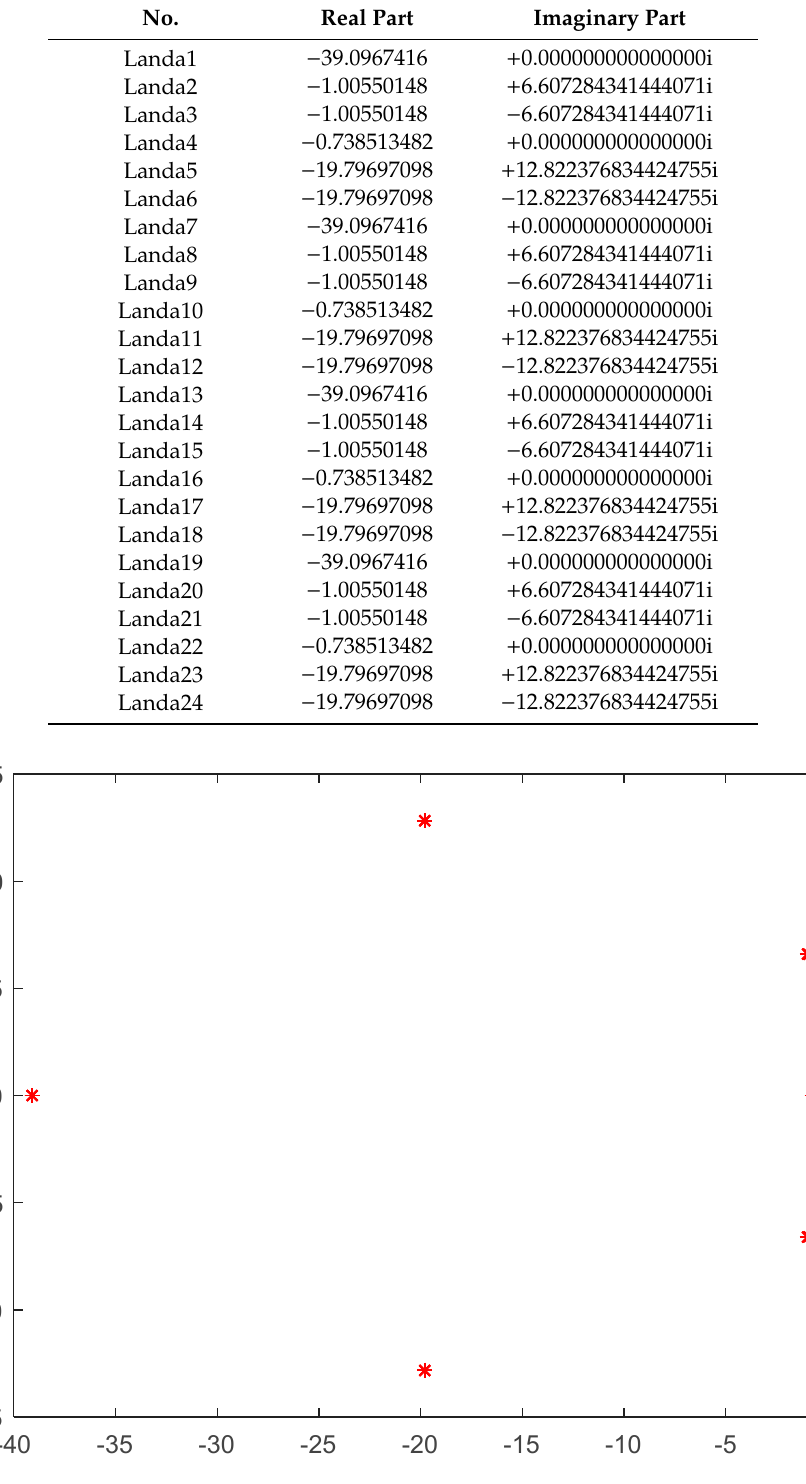
Figure 6. Location of the 24th master data on a complex surface. Table 1. The data of special matrix values.